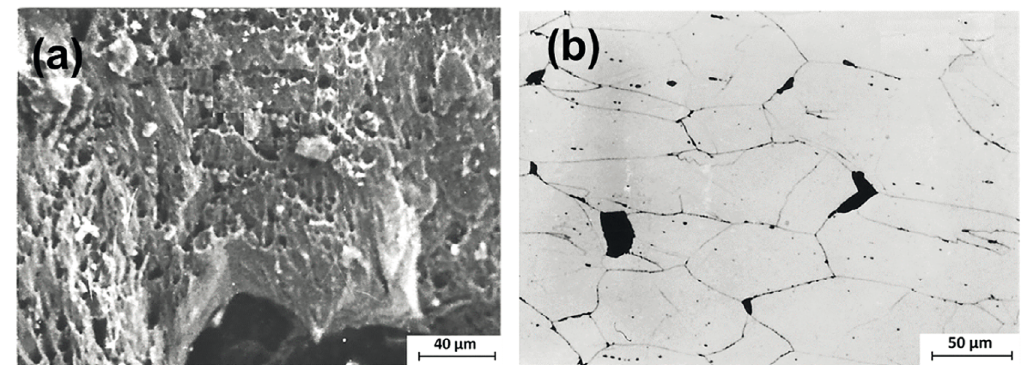
Figure 2. Ruptured tip of investigated 316 steels at 600°C: (a) SEM fractograph of SS1 steel with RA = 31% under stress of 300 MPa and (b) OM of SS2 steel with RA = 25% under 265